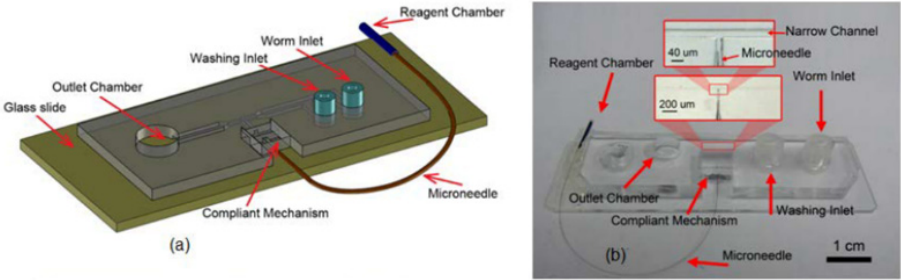
Figure 9. ( a ) A schematic and ( b ) PDMS chip of final C. elegans microinjector. Figure 9 ( a ) A schematic and ( b ) PDMS chip of final C. elegans microinjector .